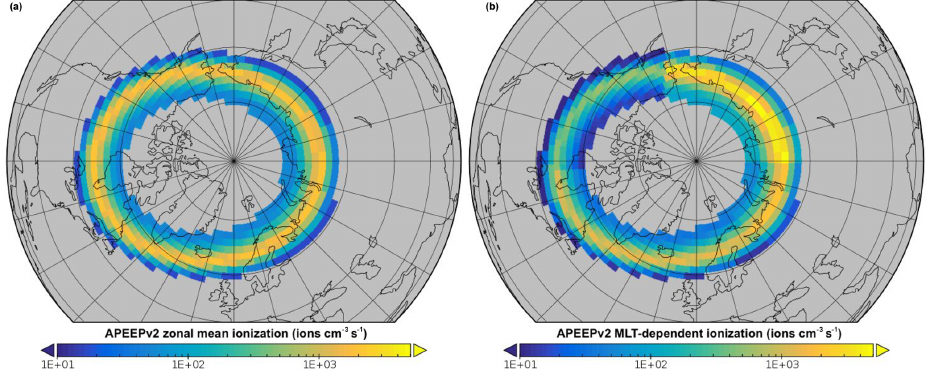
Figure 2. Extreme-case ionization rates at an approximative altitude of 75km (0.0264hPa) and midnight UT presented on the WACCM-D geographic latitude–longitude grid. (a) APEEPv2 zonal-mean forcing. (b) APEEPv2 MLT-dependent forcing over eight 3h sectors. Grey areas have no APEEP